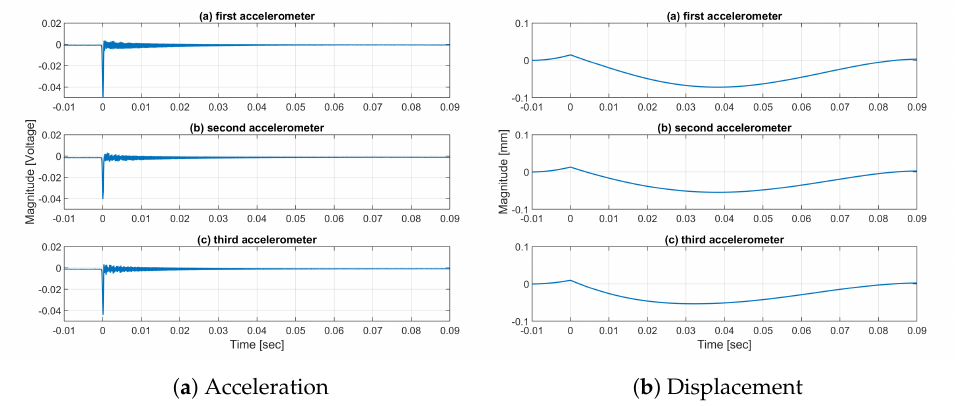
Figure 8. Typical acceleration and displacement results of the fully glued 60 grit wheel.